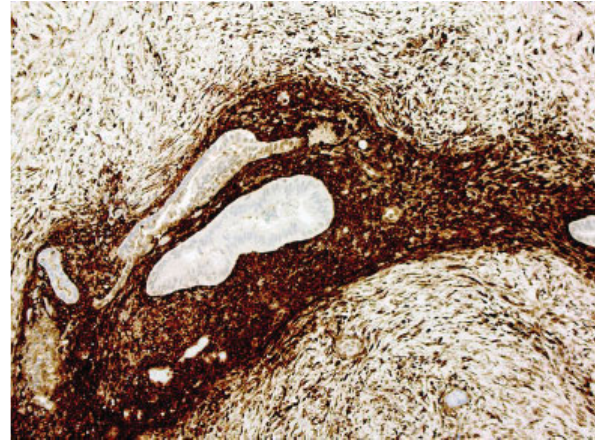
Fig. 3 Positive CD10 immunostaining con fi rmed the presence of endometrial stroma.